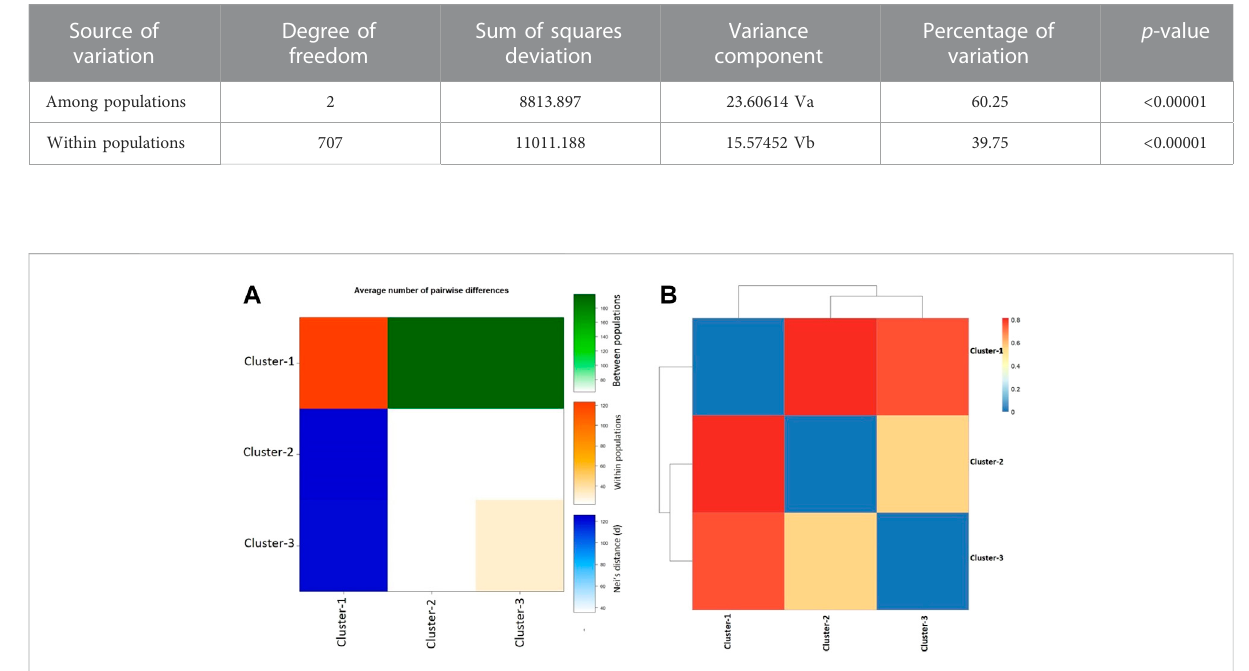
FIGURE 4 Pairwise population genetic analyses. (A) Graph represents the average number of pairwise differences ( π xy) between subpopulation clusters (green, above diagonal), within-population clusters π (orange, diagonal), and the net number of nucleotide differences between